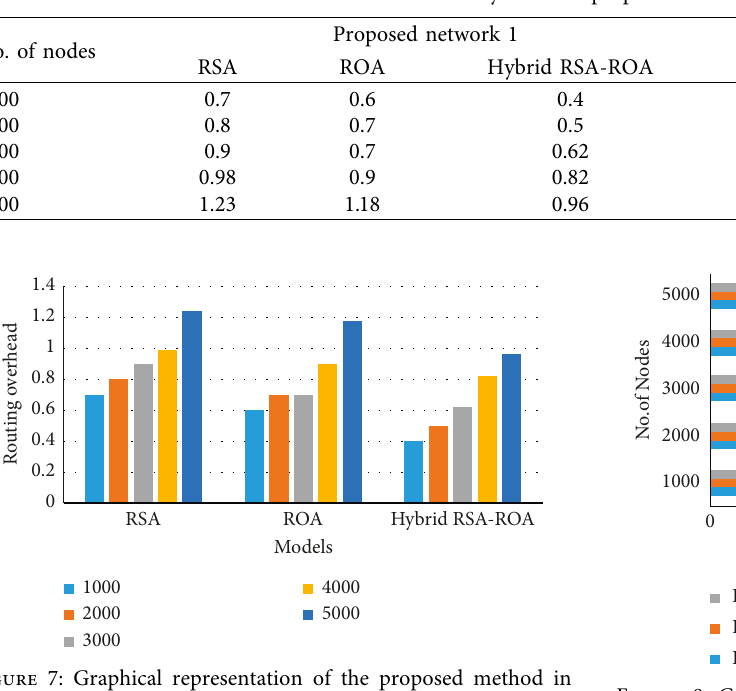
Figure 6: Graphical representation of the proposed method in terms of throughput for network 2. Table 11: Performance analysis of the proposed method for routing overhead.